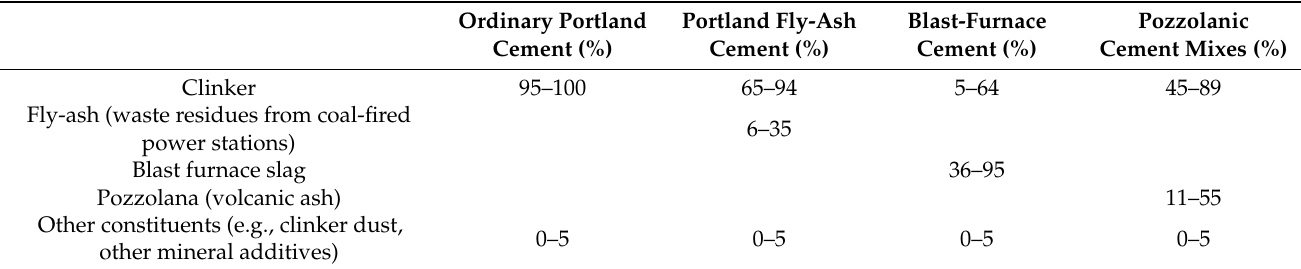
Table 6. Typical composition of different cement type [70].